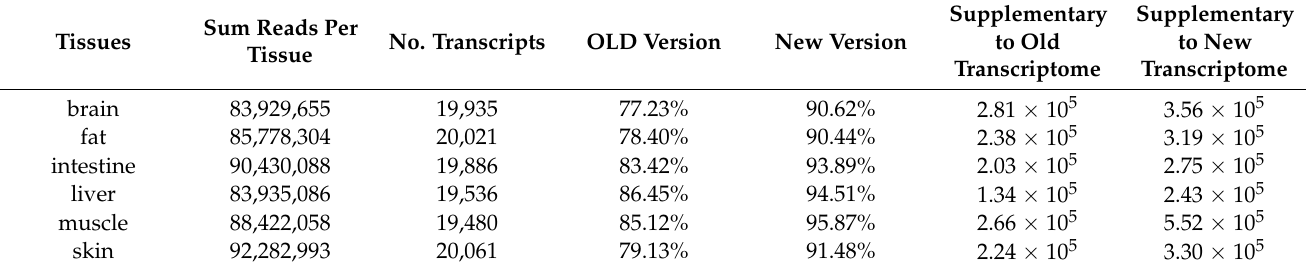
Table 1. Percentage of reads and supplementary number of reads mapped to each tissue for both versions of the O. oenanthe transcriptome. Ten percent or more of the reads that did not map to any transcripts from the previous version are now mapped to the new